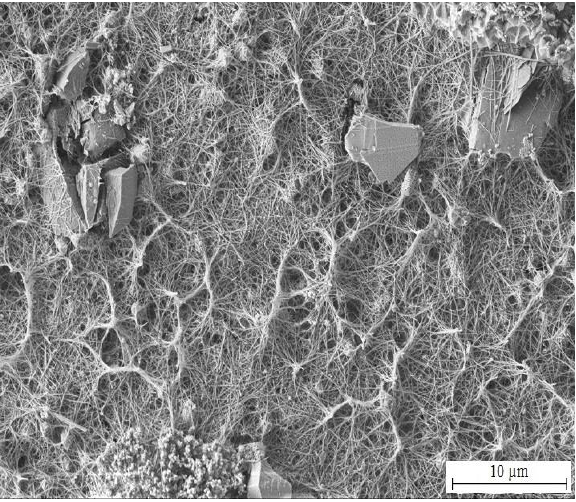
Figure 21. Detail view of precipitated corrosion products shown in Figure 20.